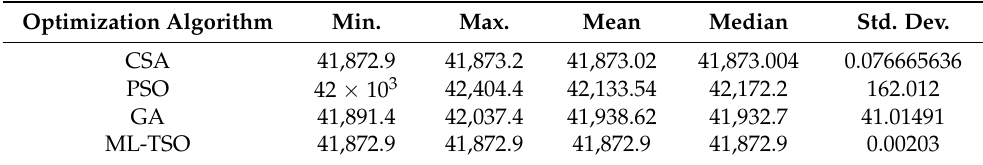
Table 3. The CSA, GA, and PSO statistical analysis results for the 57-bus test network. Optimization Algorithm